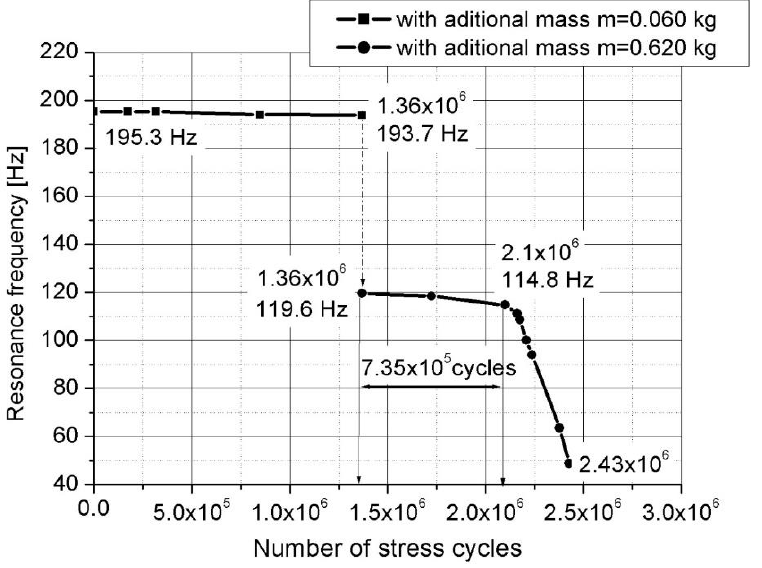
Figure 18. The variation of the resonance frequency versus the number of cumulative cycles.